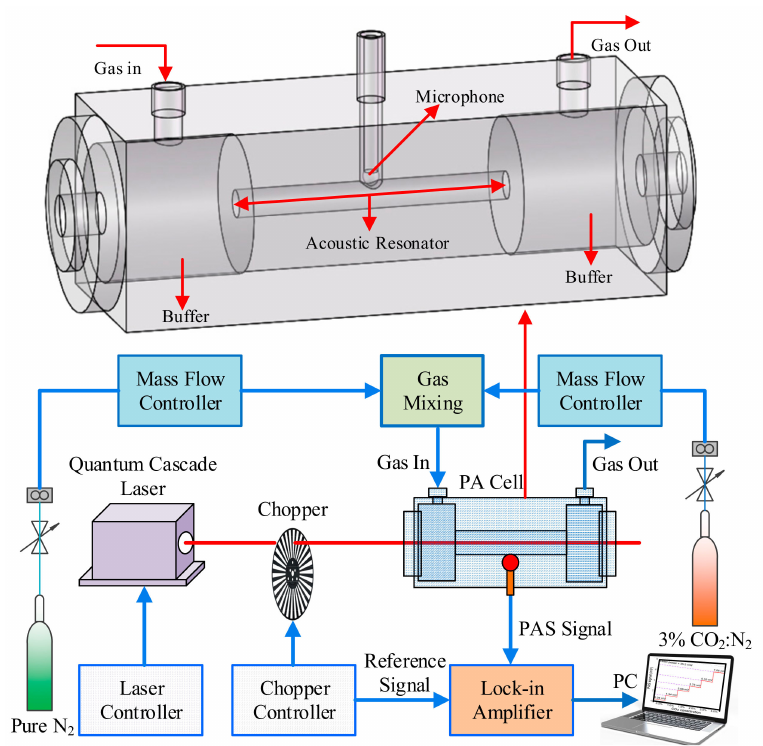
Figure 3. The Schematic of the photoacoustic spectroscopy (PAS) based CO 2 sensor system with a